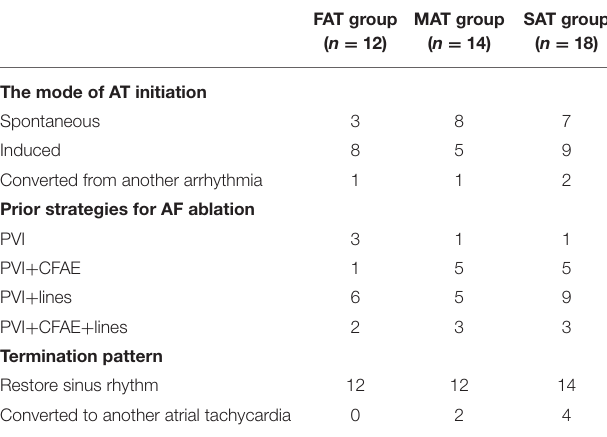
AF, atrial fibrillation; CFAE, complex fractionated atrial electrogram; FAT, focal atrial tachycardia; MAT, micro-reentrant atrial tachycardia; PVI, pulmonary vein isolation; SAT, small-loop-reentrant atrial tachycardia.